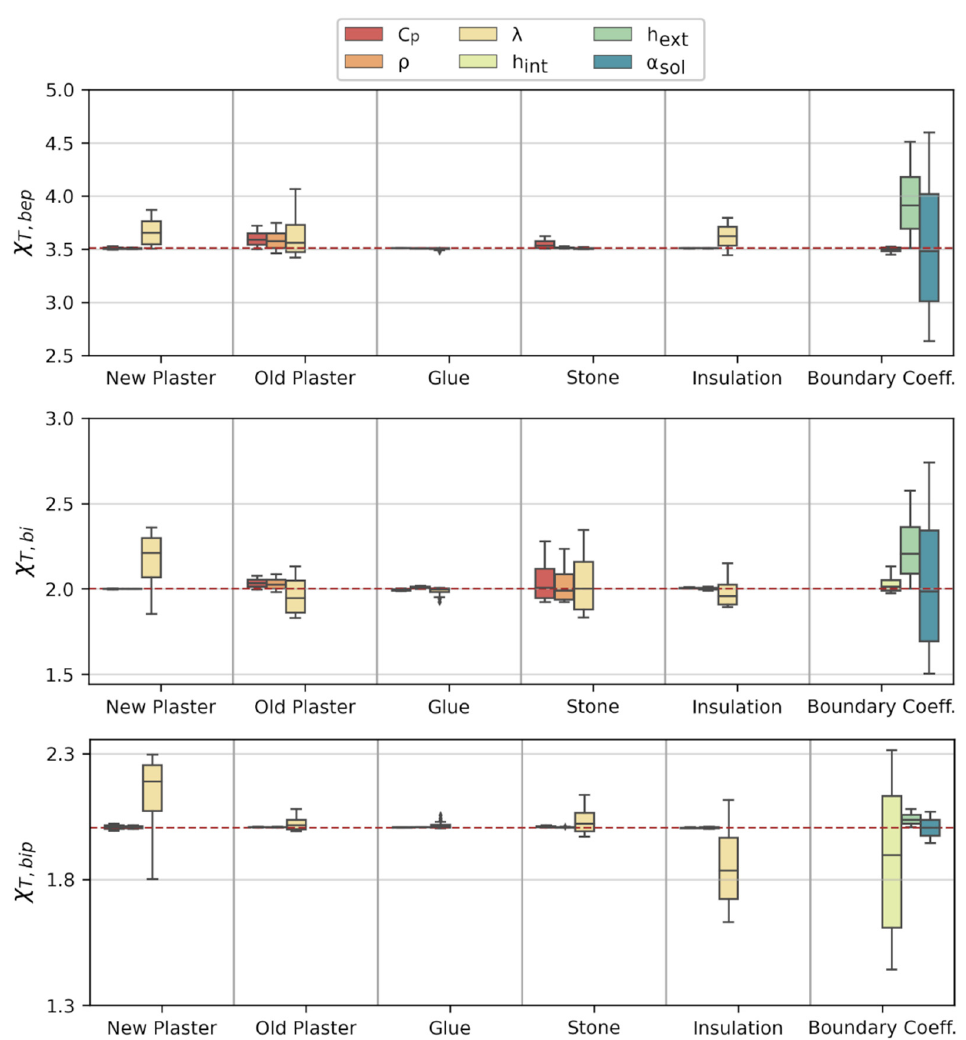
Figure 6. DSA for each monitored position ( T bep —temperature behind the external plaster, T bi — temperature behind the insulation, T bip —behind the internal plaster) in the stratigraphy.